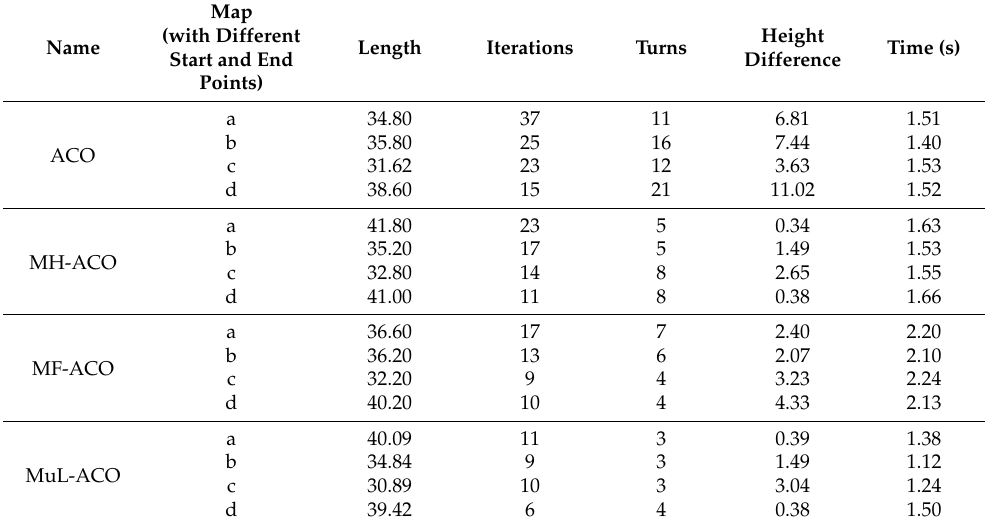
Table 5. Simulation results of ACO, MH-ACO, MF-ACO, and MuL-ACO on the map with different starting points and ending